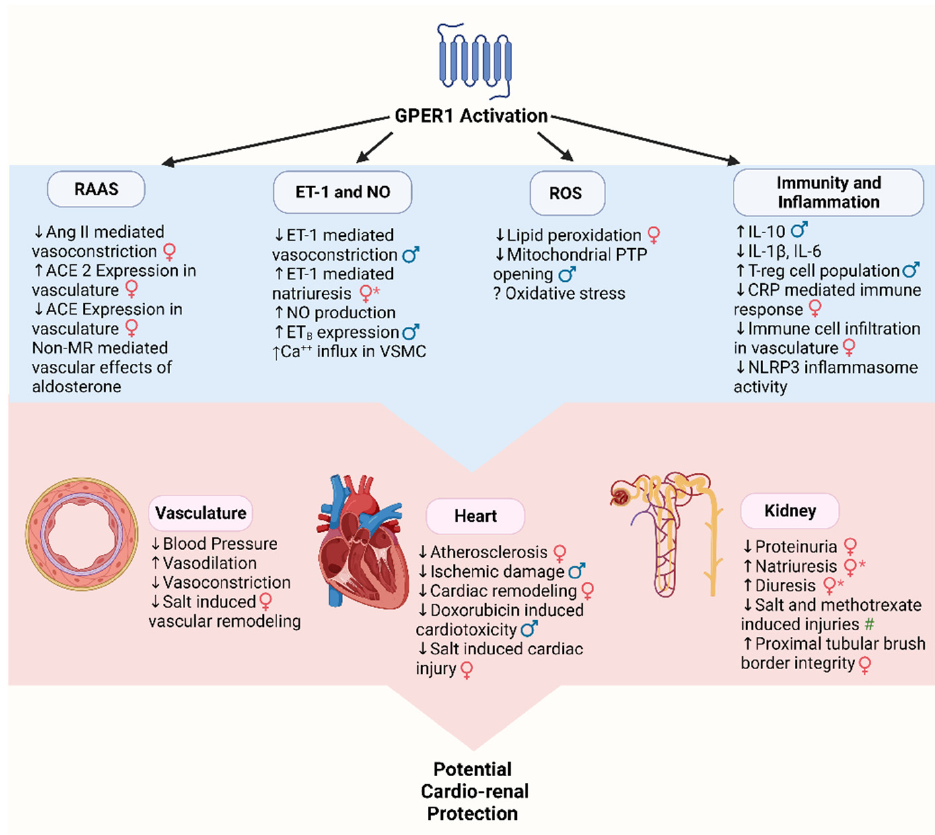
Figure 3. Mediators of GPER1 actions within the cardiovascular and renal systems. Observations reported in only one sex are denoted with the corresponding sex symbol. Observations reported in both sexes have no special designation. * Denotes sex-specific observations. # Denotes observations